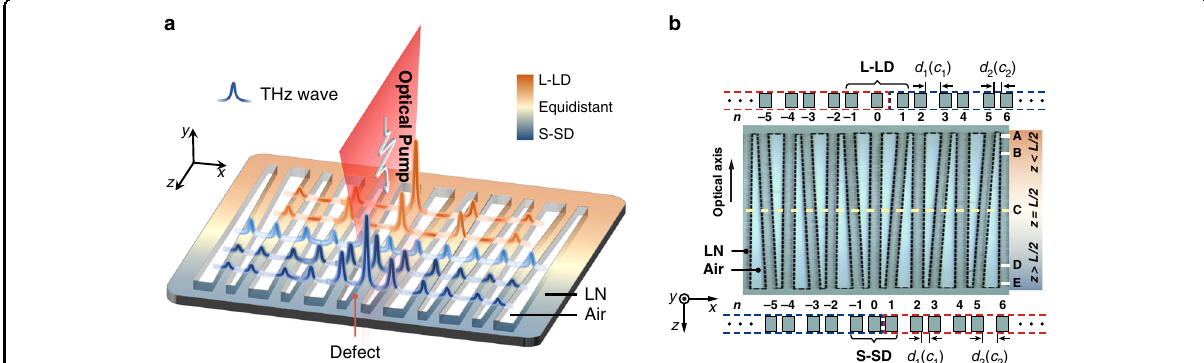
Fig. 1 Experimental realization of topologically controlled THz localization. a Illustration of nonlinear generation and con fi nement of THz- waves in an SSH-type microstructure. The LN structure undergoes a transition from L-LD, through equidistant, to S-SD regions along the + z- axis, illustrated by colors shaded from orange into blue. The polarization of the THz electric fi eld and that of the optical pump beam are all along the direction of the LN crystalline axis ( z -axis). b Microscope image of the LN array structure fabricated by fs-laser writing. The thickness of the LN chip is 50 μ m in the y -direction. The total length of the microstructure along the z -direction is L ¼ 6mm. d 1 and d 2 are the spacings between neighboring LN stripes corresponding to the coupling coef fi cients c 1 and c 2 , respectively. At the dashed yellow line, z = L /2 and d 1 = d 2 = 55 μ m, which leads to an equidistant structure. The SSH lattice contains an L-LD ( d 1 > d 2 ) region above the line and an S-SD ( d 1 < d 2 ) region below the line. A – E denote the locations corresponding to z ¼ 0, L /8, L /2, 7 L /8, L . Here n numbers the LN waveguides (lattice sites). Red and blue dashed lines mark the topologically nontrivial and trivial parts of the SSH